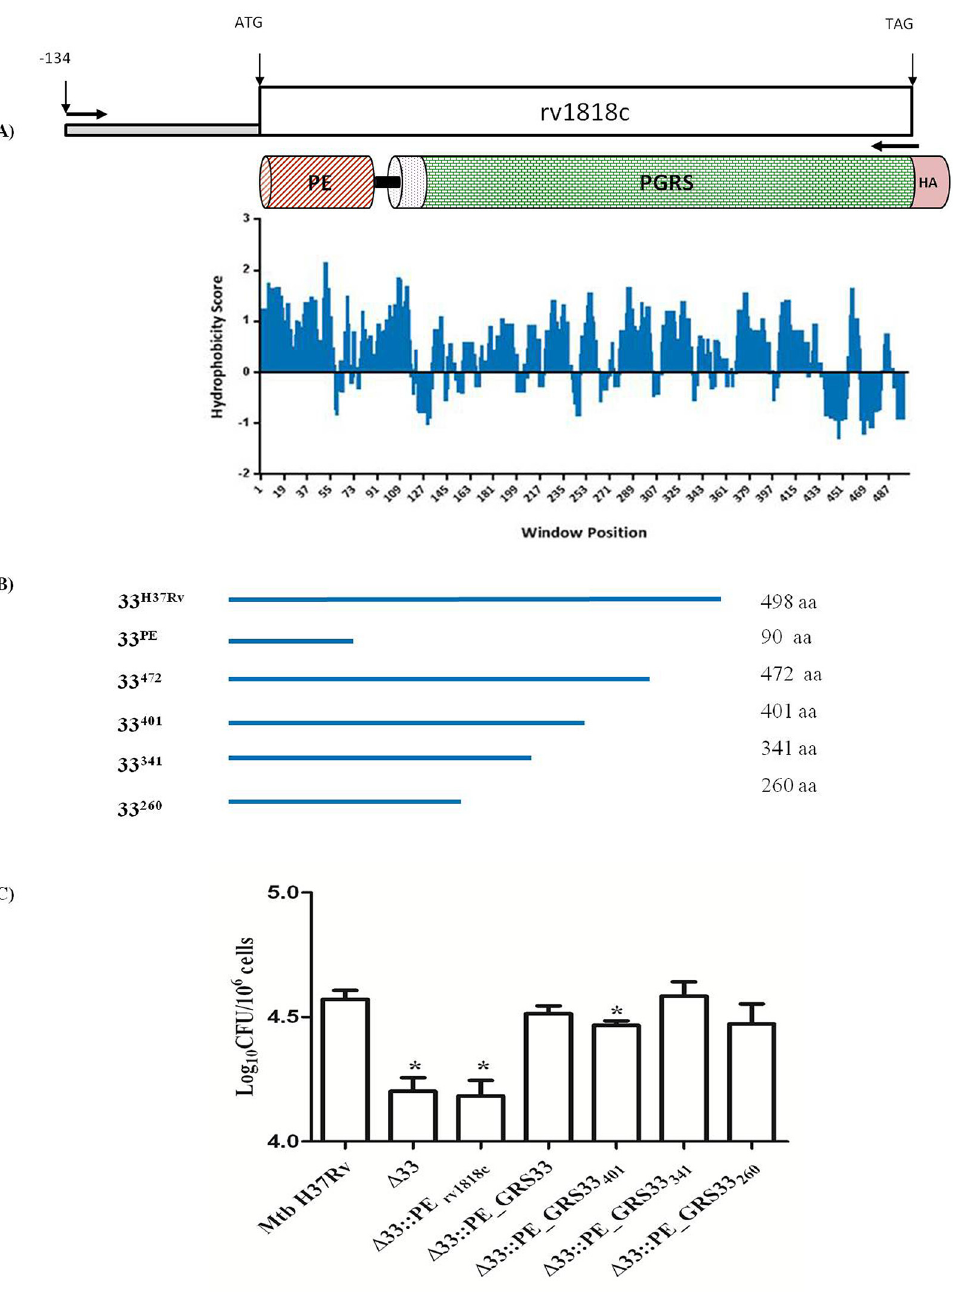
Fig 5. PE_PGRS33 encoding the first 260 amino acids is capable to mediate the entrance phenotype into macrophages. Schematic of PE_PGRS33 fragments (A-C). Truncated forms of Rv1818c were cloned downstream the native promoter PE_PGRS33 and in frame with the HA epitope sequence into the integrative plasmid pMV306. A) Rv1818c gene and its native putative promoter located 134 nucleotides upstream the start codon. Schematic overview showing PE_PGRS33 domains: PE domain (red stripped), transmembrane region (magenta dotted), PGRS domain (green netting), HA epitope (rose). The hydrophobicity profile of PE_PGRS33 was obtained using CLC Main Workbench 6.9 (Kyte-Doolittle scale, window size 9). B) Stylized representation of full- length PE_PGRS33, PE domain and the 472, 401, 341 and 260 amino acid in length fragments (blue lines). Cloning and protein information are reported beside. C) pMM0 isolated from C57BL/6 mice were infected at a MOI of 1:10 with Mtb H37Rv, Mtb Δ 33, Mtb Δ 33::PE_PGRS33HA and complemented strains expressing the 4 PE_PGRS33 functional deletion mutants. Intracellular CFUs were enumerated at 4h post-infection. Results of one representative experiment of at least three assays are shown. * p < 0.05 for Mtb H37Rv vs Mtb Δ 33::PE_PGRS33 401 and *** p < 0.001 compared with for Mtb H37Rv vs Mtb Δ 33 and Mtb Δ 33::PE Rv1818c. CFUs were expressed as mean ± SD and were analysed by one-way ANOVA followed by Dunnett ’ s multiple comparison